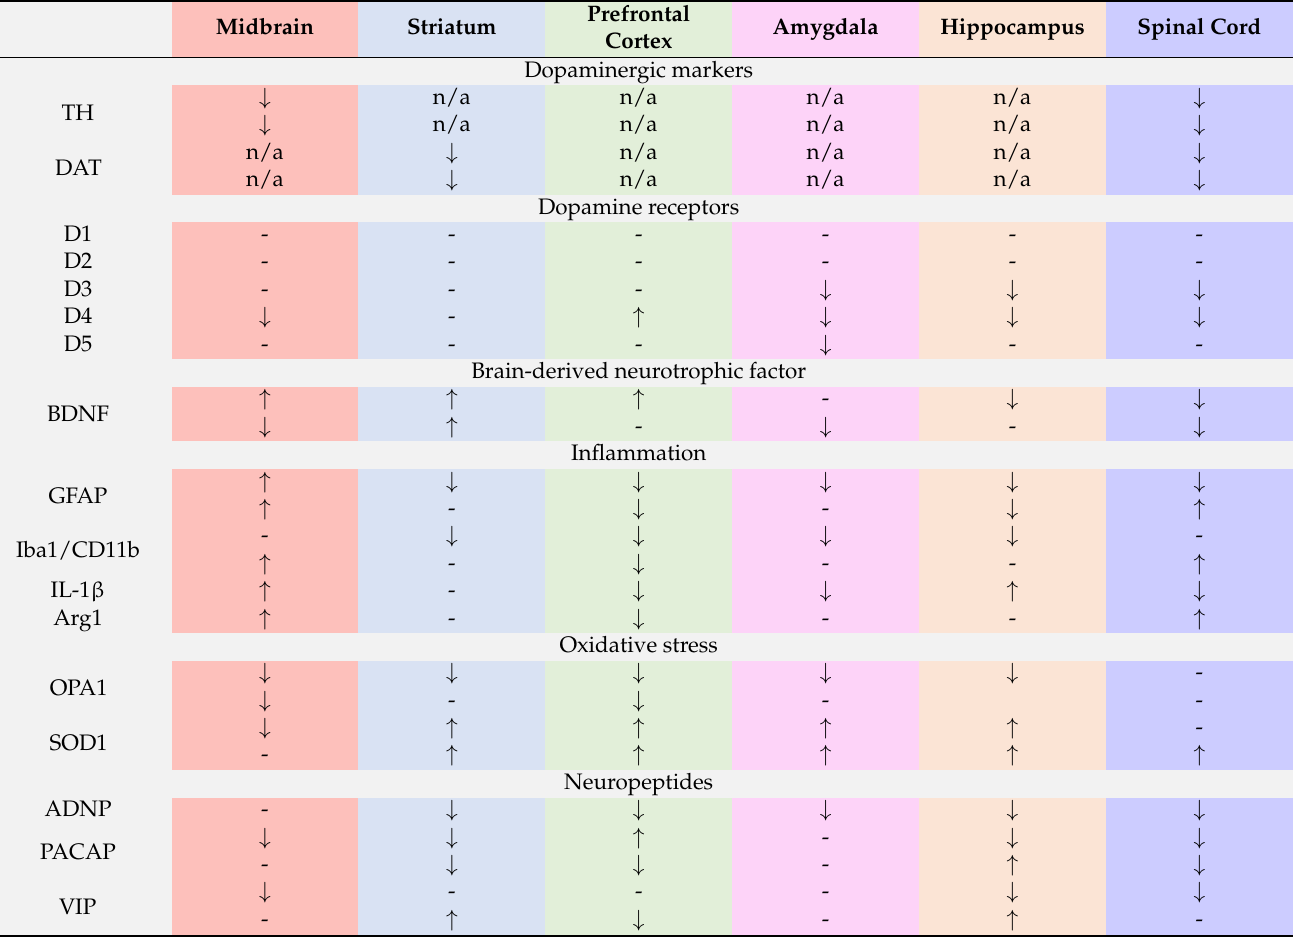
Table 3. Summary of